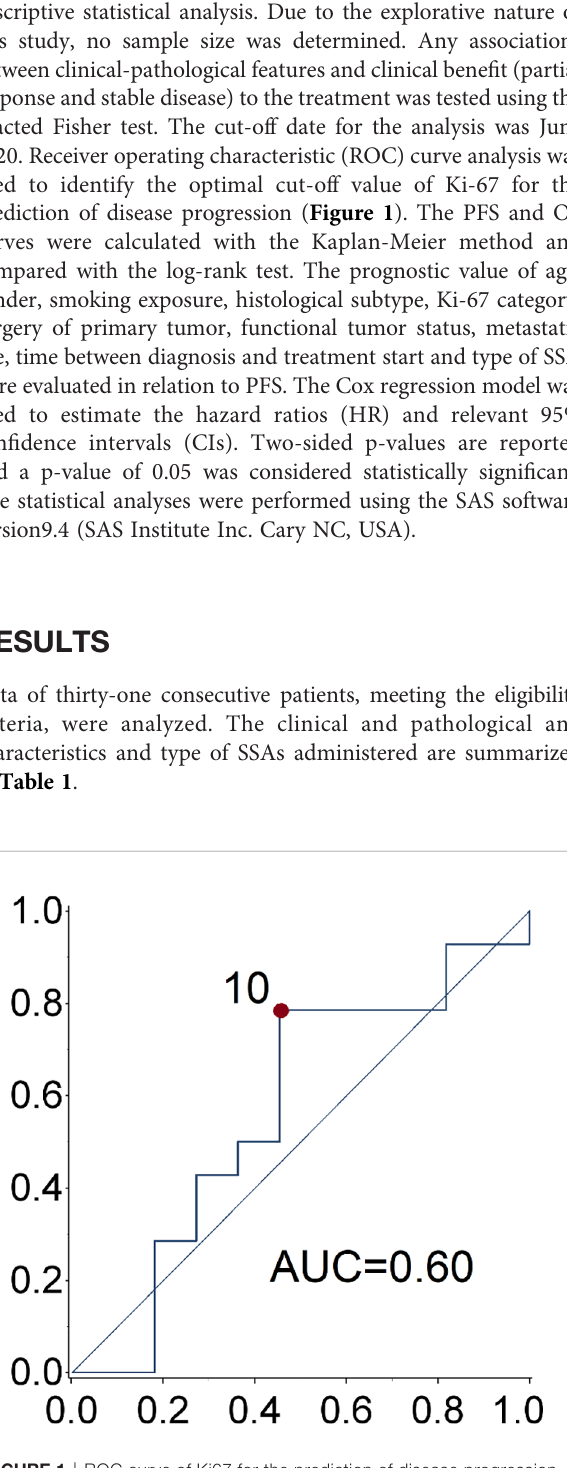
FIGURE 1 | ROC curve of Ki67 for the prediction of disease progression. The optimal ki-67 cut-point maximizing the Youden index for the prediction of disease progression at 28.6 months (median progression free survival) is